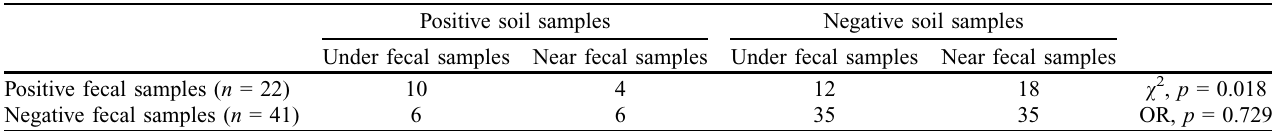
Table 4. Parasitological status ( E. multilocularis and/or Toxocara spp.) of soil samples depending on where they were collected (under or near a fecal sample) and the parasitological status of the fecal sample. A positive correlation for the parasitological status was considered present only for the detection of the same parasite (i.e. E. multilocularis or Toxocara spp.) in both fecal and soil samples.